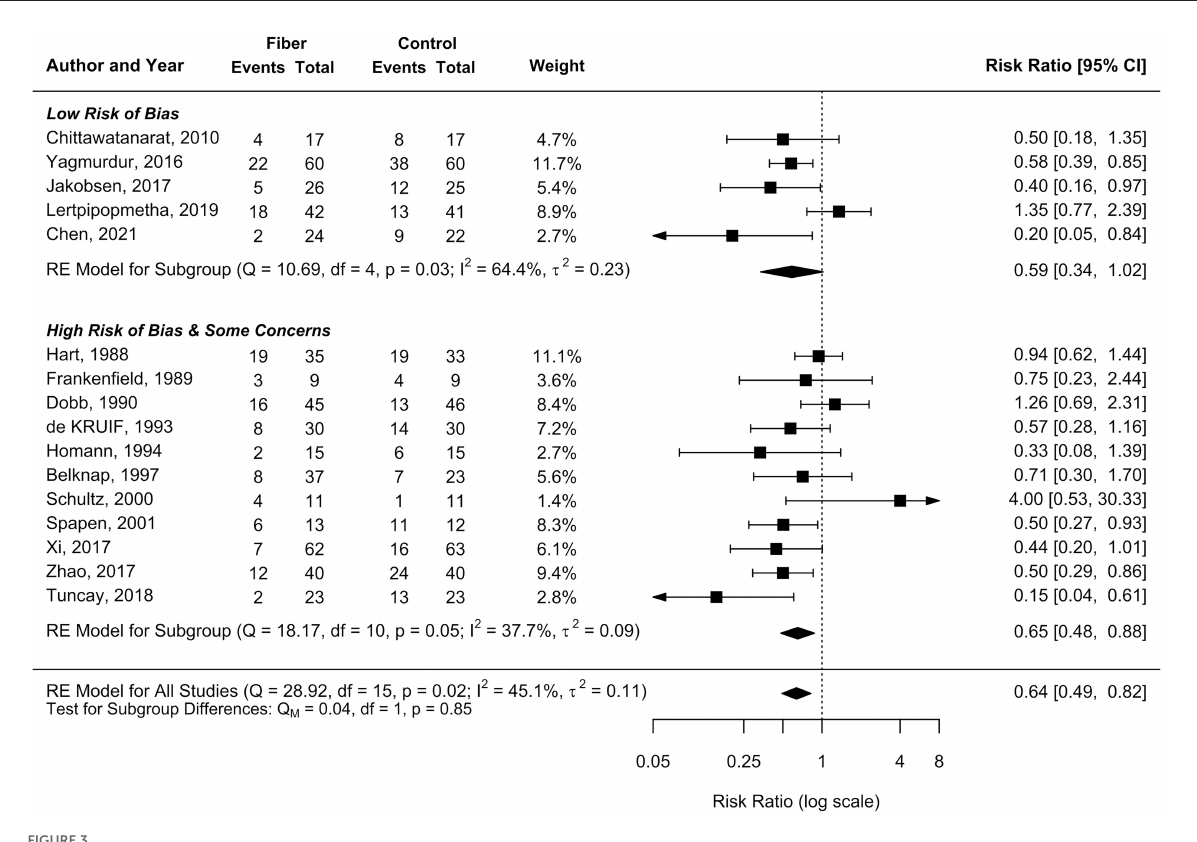
FIGURE3 Subgroup by risk of bias on the effect of EN containing fiber supplements on the incidence of